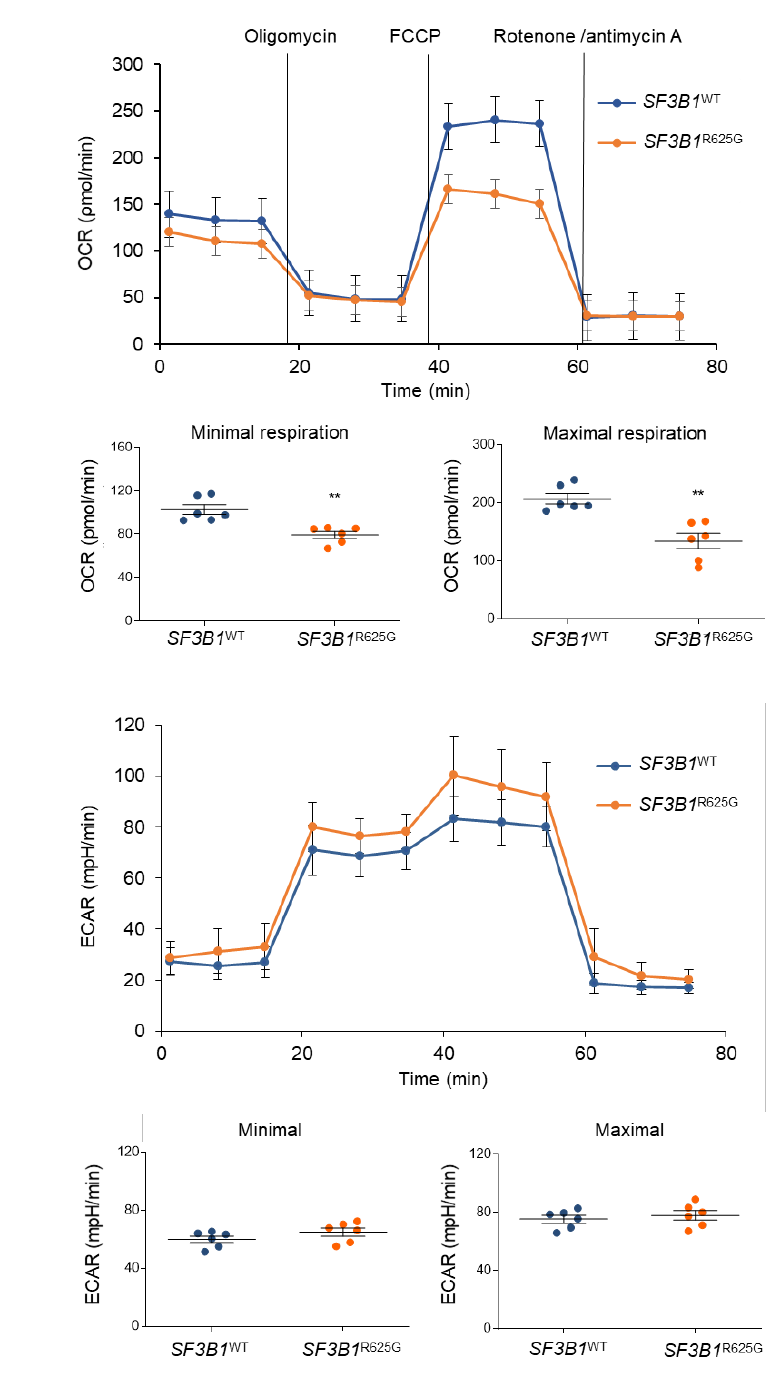
Figure 4. SF3B1 R625G triggers a decrease in mitochondrial respiration. ( A ) Oxygen consumption rate (OCR) of SF3B1 WT (blue) and SF3B1 R625G (orange) isogenic Mel202 cells as measured by Seahorse